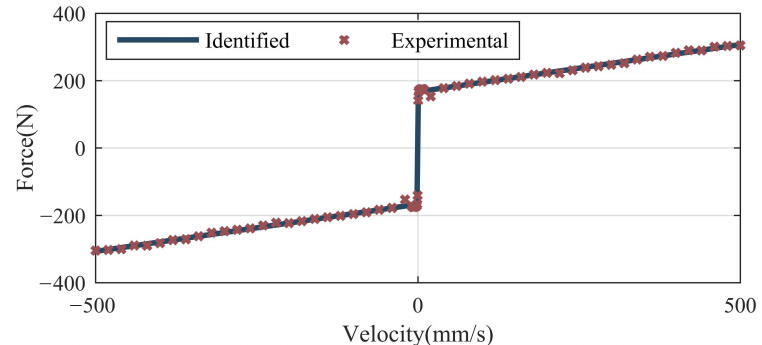
Figure 9. Friction force curve of the electric cylinder and the gas